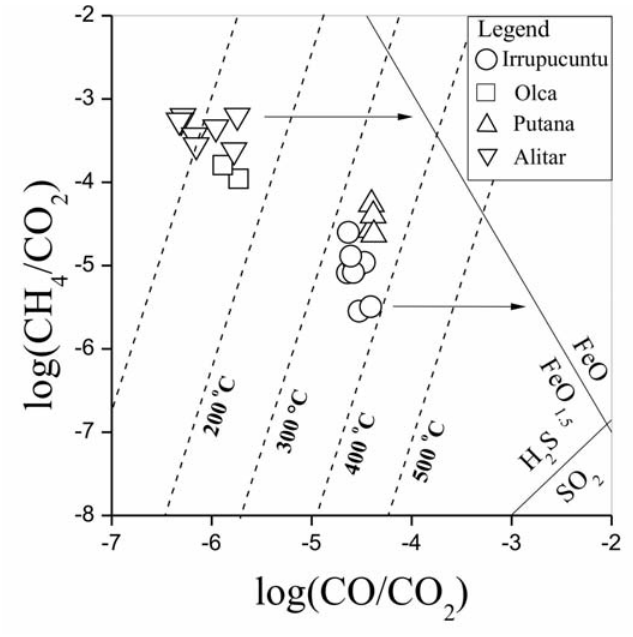
Figure 11. Log(CH /CO ) versus log(CO/CO ) diagram. Solid lines refer 4 2 2 to equilibria controlled by the FeO-FeO and the SO -H S redox pairs. 1.5 2 2 Dashed lines are the calculated isotherms for the simultaneous equilibrium -H O and the CO-CO geothermometers. Symbols as in legend of the H 2 2 2 to Figure